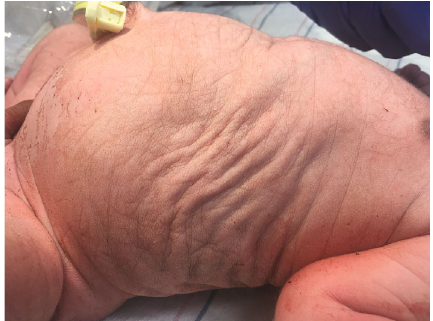
Figure 1: Note the wrinkled, fl accid, and thin abdominal wall.